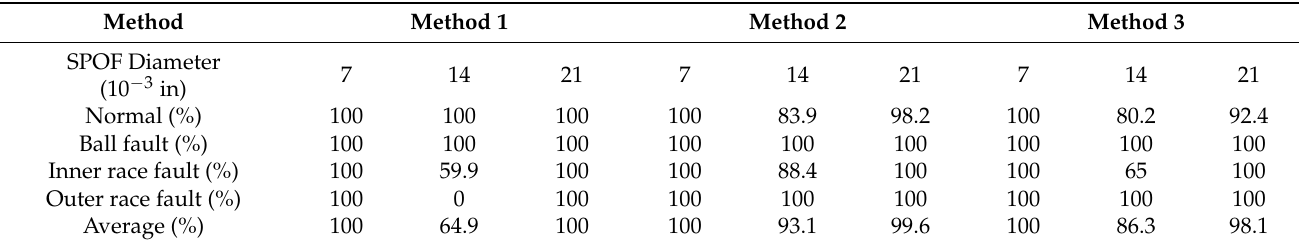
Table 8. Accuracy When HP =